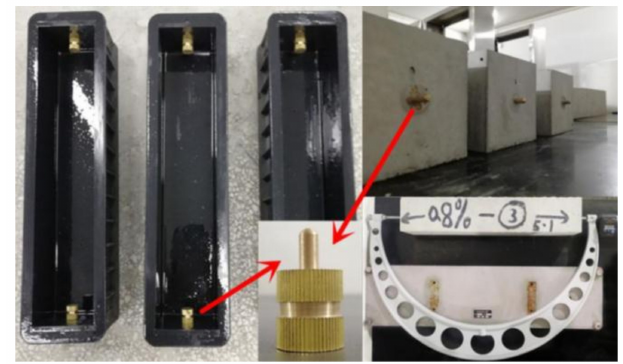
Figure 4. Measuring of drying shrinkage for self-compacting SFRC.